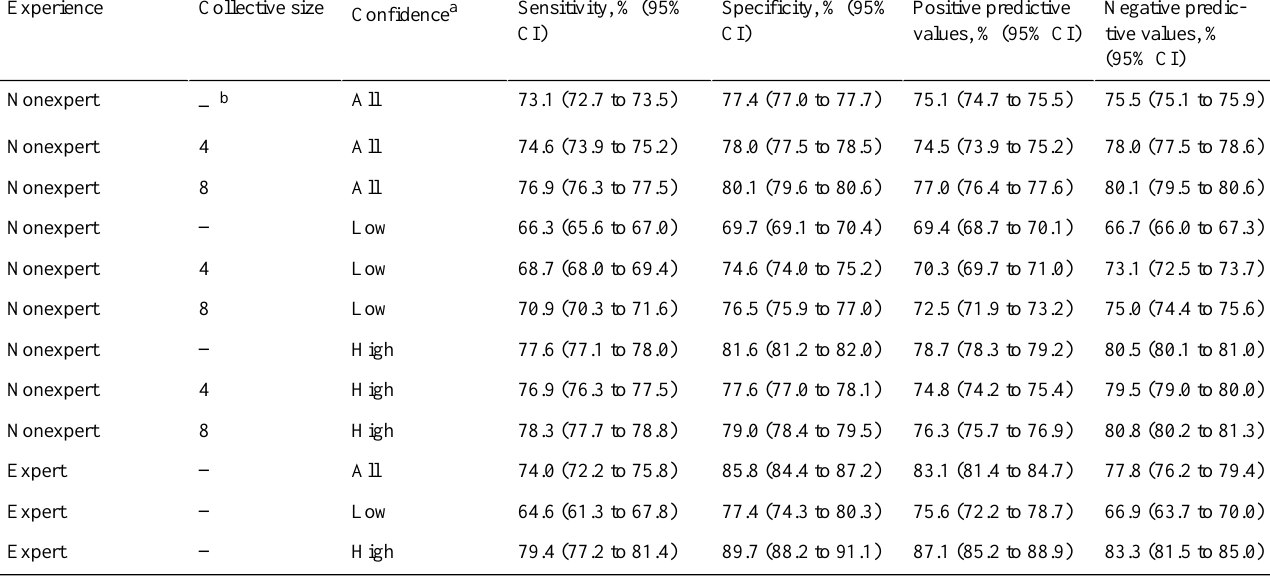
Table 2. Diagnostic values measuring detection of malignant skin lesions for different confidence